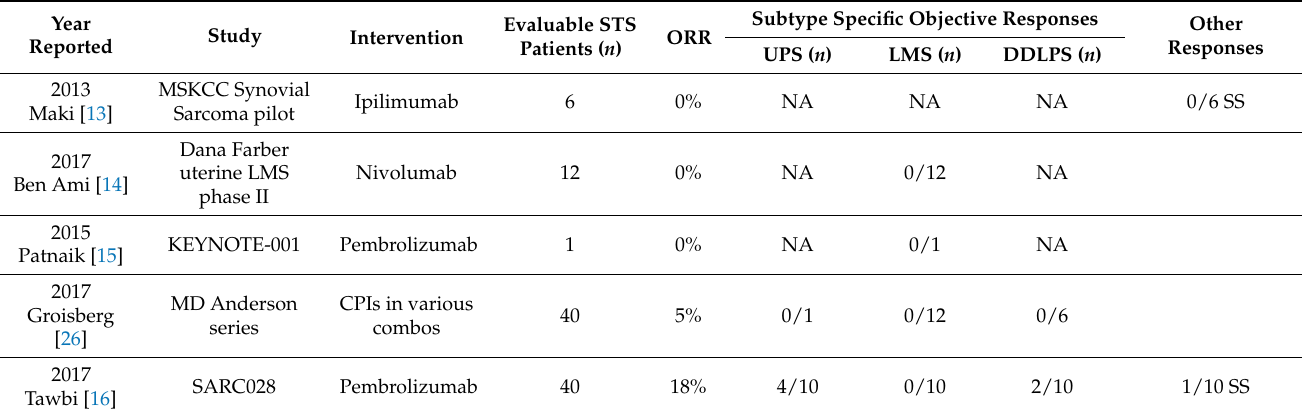
Table 1. Clinical trials and reports exploring the use of CPIs in